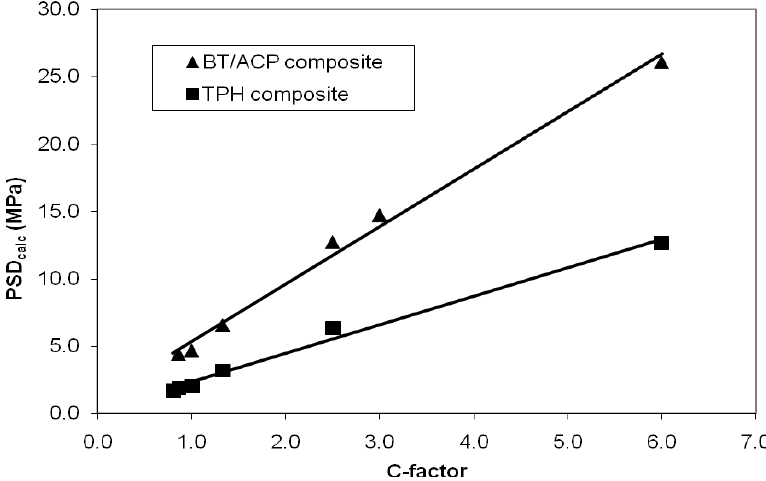
on the cavity configuration factor. The average calc data (n = meas